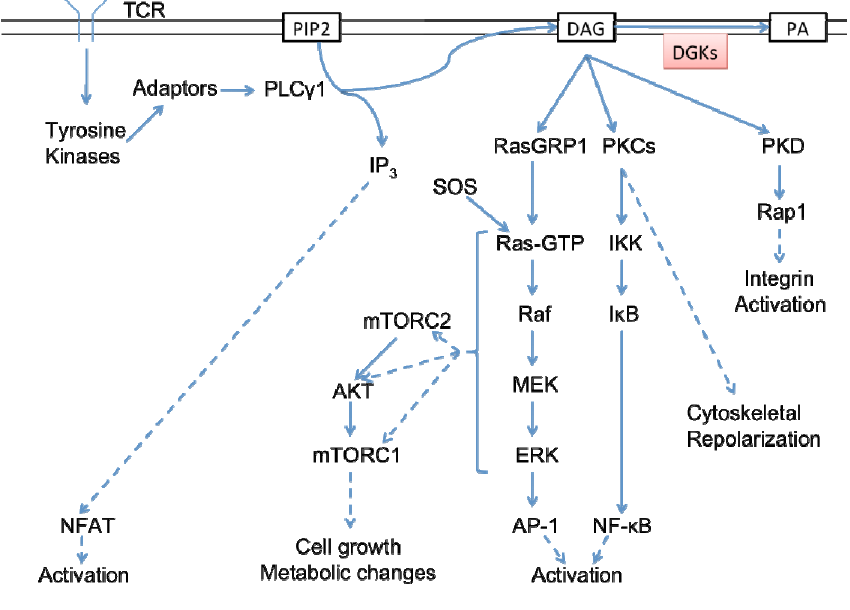
Figure 2. Diacylglycerol has a central role in TCR signaling. Engagement of the TCR leads to the activation of tyrosine kinases and the formation of a multimolecular complex including adapter proteins. PLC γ 1 is recruited to and activated by this complex and in turn hydrolyses the phospholipid PIP to form membrane-diffusible diacylglycerol (DAG) and 2 . DAG activates proteins including RasGRP1, PKCs, and PKD. Activation of cytosolic IP 3 RasGRP1 leads to Ras and AKT pathway activation. Activation of PKCs leads to the activation of NF- κ B and cytoskeletal repolarization. Activation of PKD leads to integrin Ras, and PKC- θ signaling cooperate to promote T cell activation through activation. IP 3, the transcription factors NFAT, AP-1, and NF- κ B, respectively. Diacylglycerol kinases (DGKs) phosphorylate DAG to form phosphatidic acid (PA), thereby potentially regulating a broad set of signaling pathways downstream of the